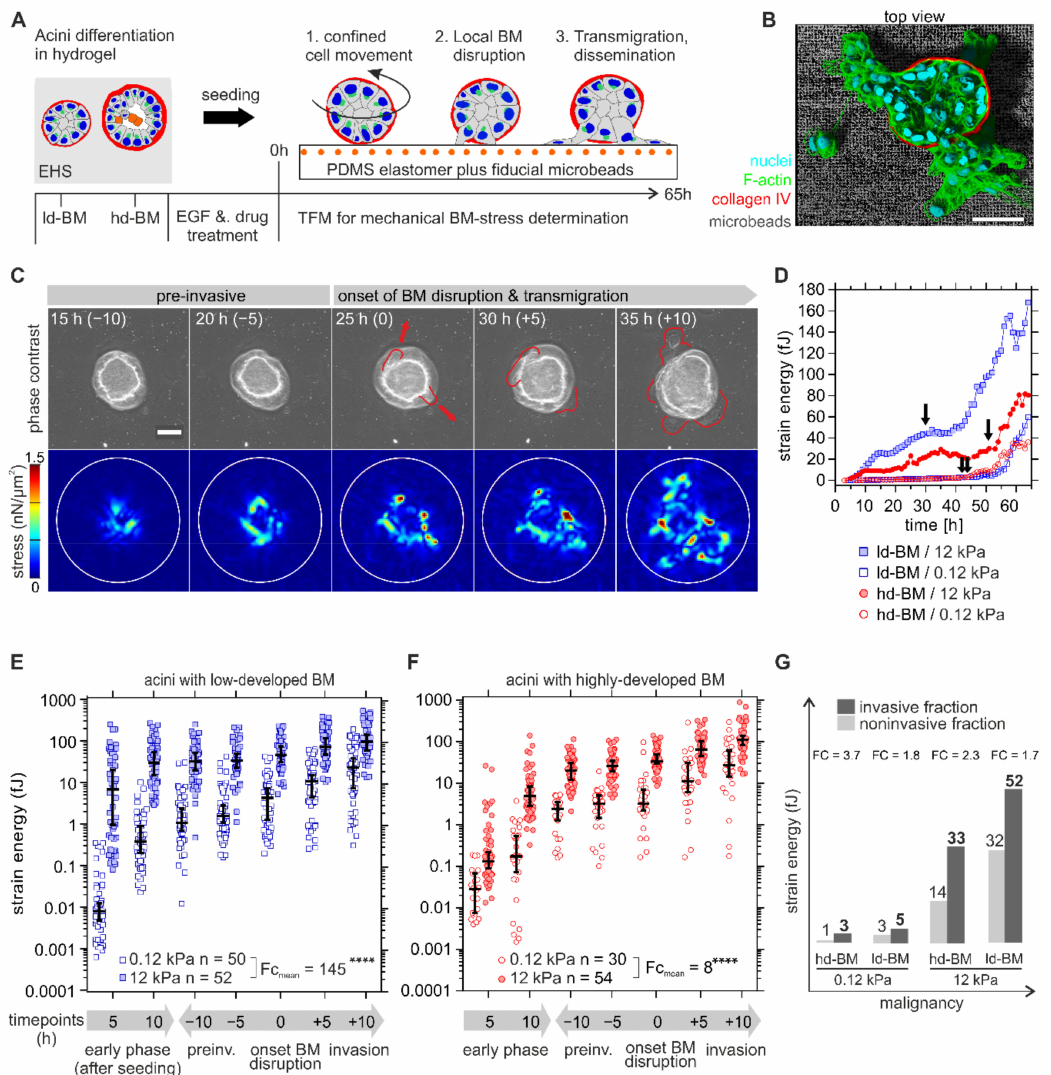
Figure 2. Mechanical BM stress exertion by benign breast acini. ( A ) Scheme of the designed traction force microscopy (TFM) assay to determine invasion-associated physical BM stress. The experimental workflow illustrates the general sequence of events in response to BM developmental stage, substrate stiffening, and EGF stimulation on cell invasion. ( B ) 3D rendered image shows an invasive hd-BM acinus on a stiff TFM substrate (12 kPa PDMS rubber) and incorporated fluorescent fiducial microbeads. ( C ) Representative TFM image sequence showing tangential mechanical stress exerted at the BM–substrate interface by an ld-BM acinus (+EGF) on 12 kPa substrate at timepoints before (pre-invasive), at BM disruption and during cell transmigration. Upper row: phase-contrast images illustrate the first appearance of protrusive cell bodies (red outlines), marking the onset of BM disruption and transmigration. Timepoints (in brackets) correspond to the dichotomized x -axis used in ( E – G ). Lower row: matching stress maps (nN/ µ m 2 ) used for strain energy calculation. White outlines: ROI for strain energy calculation. ( D ) Representative strain energy regimes of individual acini (continuous TFM data, arrows indicate BM disruption events). ( E , F ) Overall comparison of detected strain energies (BM stress) according to altered BM and ECM conditions. X -axis: the first 5 and 10 h after acini seeding define the early phase . Other timepoints are normalized to the individual onset of BM disruption (=0 h) and dichotomized into comparable pre- (“- hours”) and post-invasive (“+ hours”) phases (see Table S2 for exact median strain energy values plotted in ( E , F )). ( G ) The graphic illustrates the relationship between BM stress and malignancy. A grouped comparison of median strain energies at matching timepoints in non-invasive (at measurement intervals of 20, 30, 40, 50, 60 and 65 h) and invasive fractions (at timepoints of BM invasion) depending on ECM conditions. FC: calculated from median values. Scatter bars: median with 95% CI. n: the invasive sample size of at least three independent experiments. Mean fold change (FC mean ): the ratio of all median strain energies averaged over all timepoints. Scale bars: 50 µ m; ****: p <